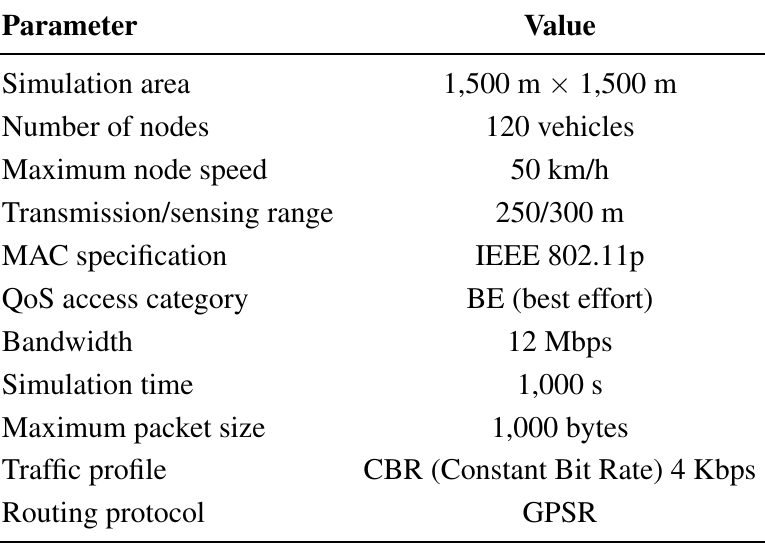
Table 3. The main simulation setting used in the distance